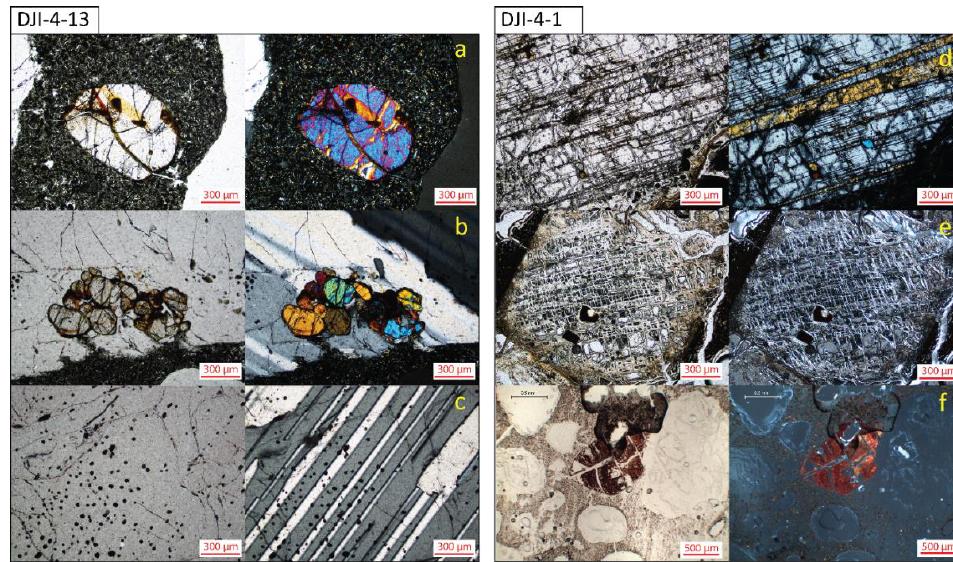
Figure 11. Close-up views of thin sections in natural light and polarized light. DJI-4-13 (fresh basalt): ( a ) olivine crystal showing multiple fractures and iddingsite forms; ( b ) olivine aggregate in a plagioclase with iddingsite forms; ( c ) multiple fluid inclusions in plagioclases. DJI-4-1 (altered basalt): ( d ) partially altered and densely fractured plagioclase with some unaltered clinopyroxenes; ( e ) plagioclase completely altered in clay showing a fracture network corresponding to and perpendicular to the original polysynthetic macle; ( f ) Mn-Fe oxide between the relics of plagioclase crystals. The altered plagioclase porphyritic basalt samples (Figure 10b) show a porosity up to 50% and are poorly consolidated: they are prone to crumbling when touched. These samples